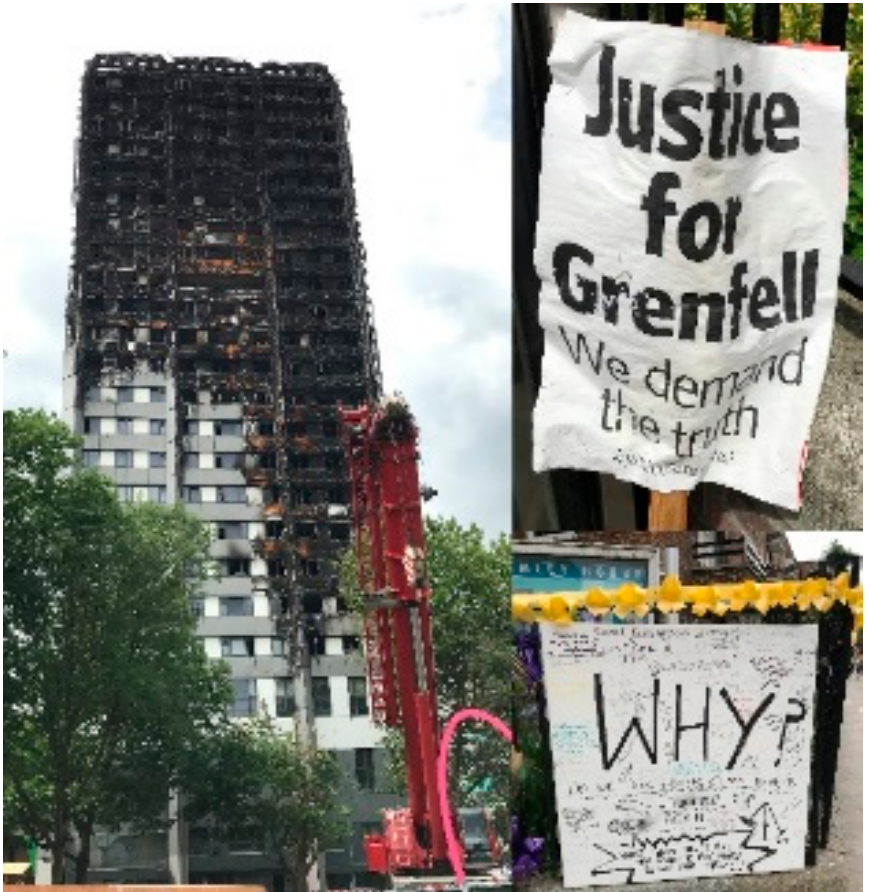
Figure 7. The devastating fire in Grenfell Tower in London, which cost 72 lives, was fueled, in part, by the same components we seek to improve thermal performance and reduce energy use in